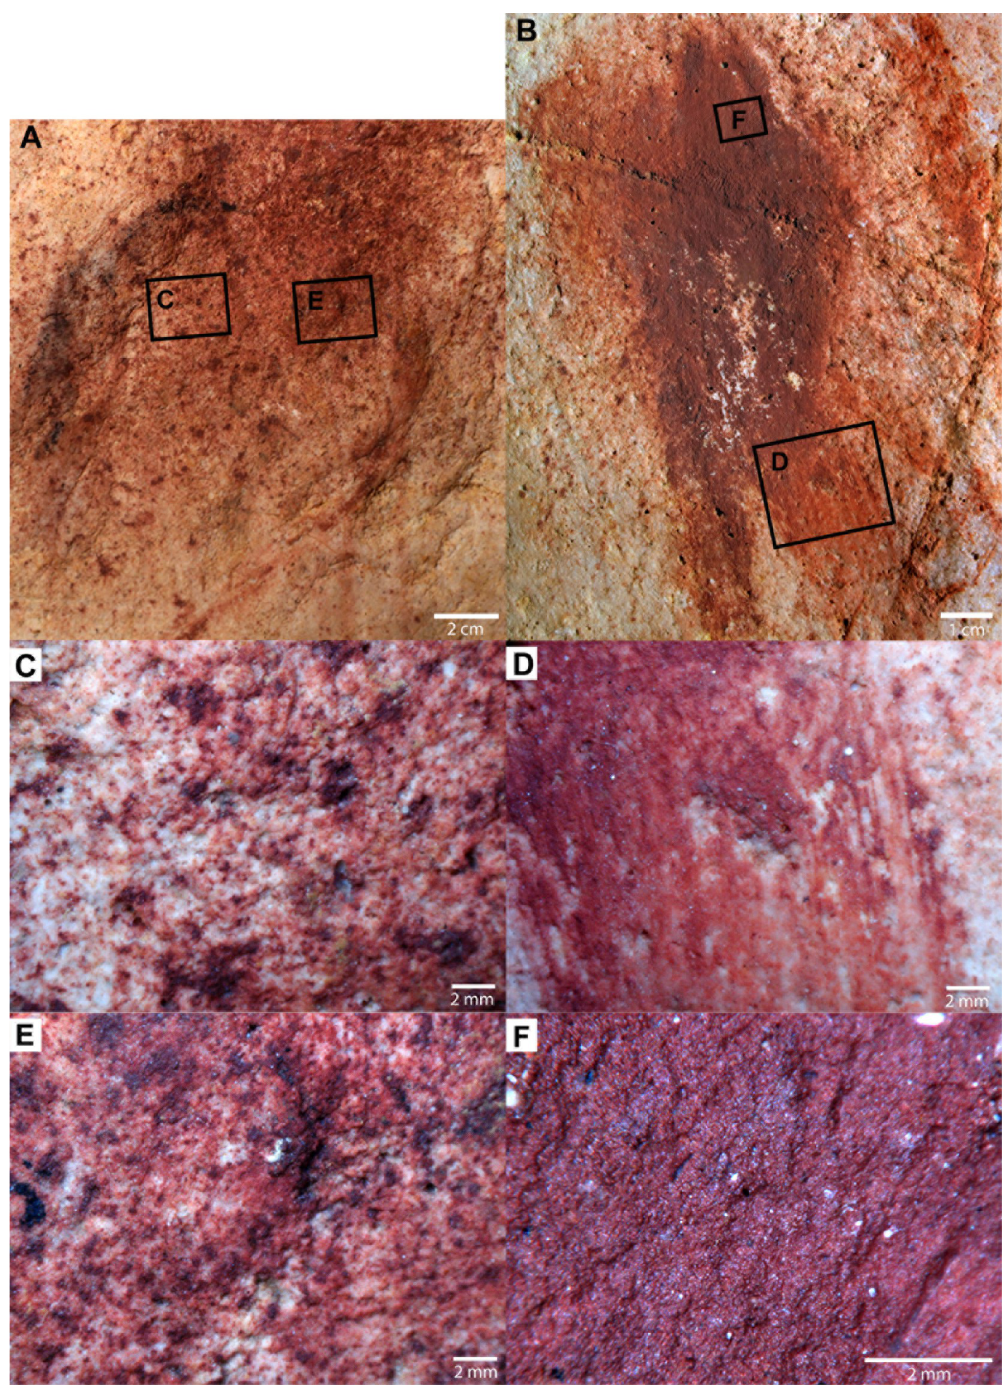
Fig 4. Macro and microphotographs of the paintings H105 (A, C, E) and H103 (B, D, F). Colours are not calibrated, which explains the differences in colour between the macro and microphotographs. The light conditions were identical. in S1 (Table 3). The Fe peaks is higher in paint H1. This is consistent with its higher Fe con- tent. The Ca K peaks are very similar, while the Ar K-alpha peak (present in the air) is a little higher in S1. This pattern indicates a possible difference in air thickness between the two